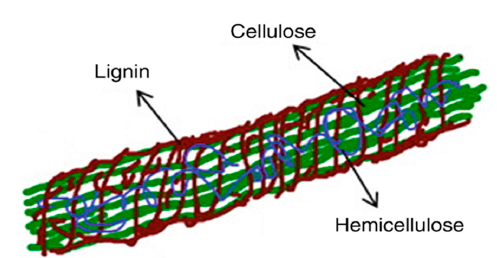
Figure 6. Hierarchical structure of lignocellulosic biomass.